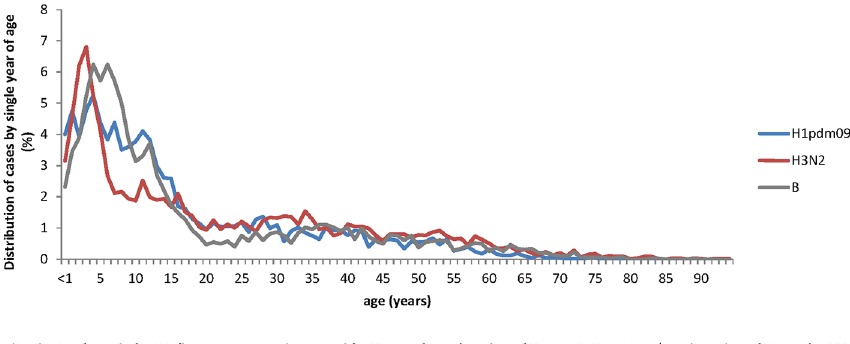
Fig 2. Age distribution of influenza cases by virus type and subtype. The IBVD (Influenza B in Vircases database) study, France, 2003 – 2004 to 2012 – 2013. The age distribution of H3N2 cases is shown in red, B cases in grey and H1pdm09 in